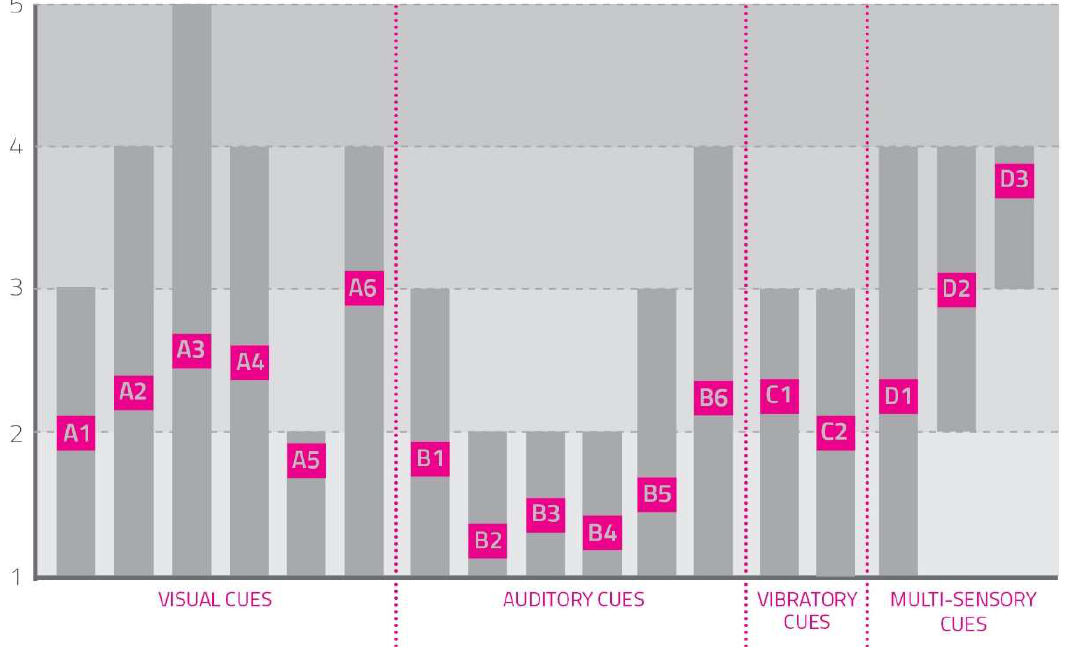
Figure 2. How invasive and annoying were the cues? The rectangles in the figure represent the answers given by users, their median values (the pink squares containing the name of the single cue), and distribution and variability (the length and placement of the gray rectangle).